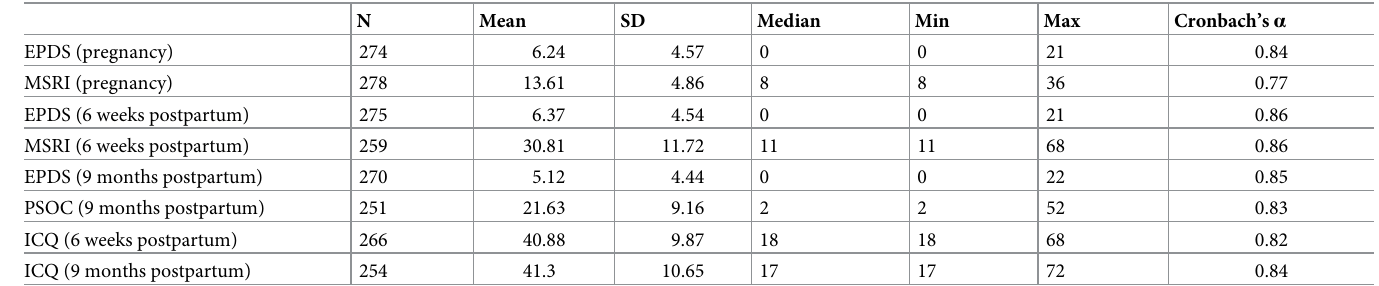
Table 2. Descriptive statistics for the EPDS, MSRI, PSOC and ICQ.